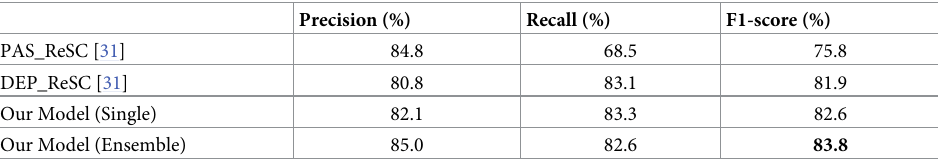
Table 8. Comparison of in vivo PK DDI results of our model and those of existing models. Precision (%) Recall (%)